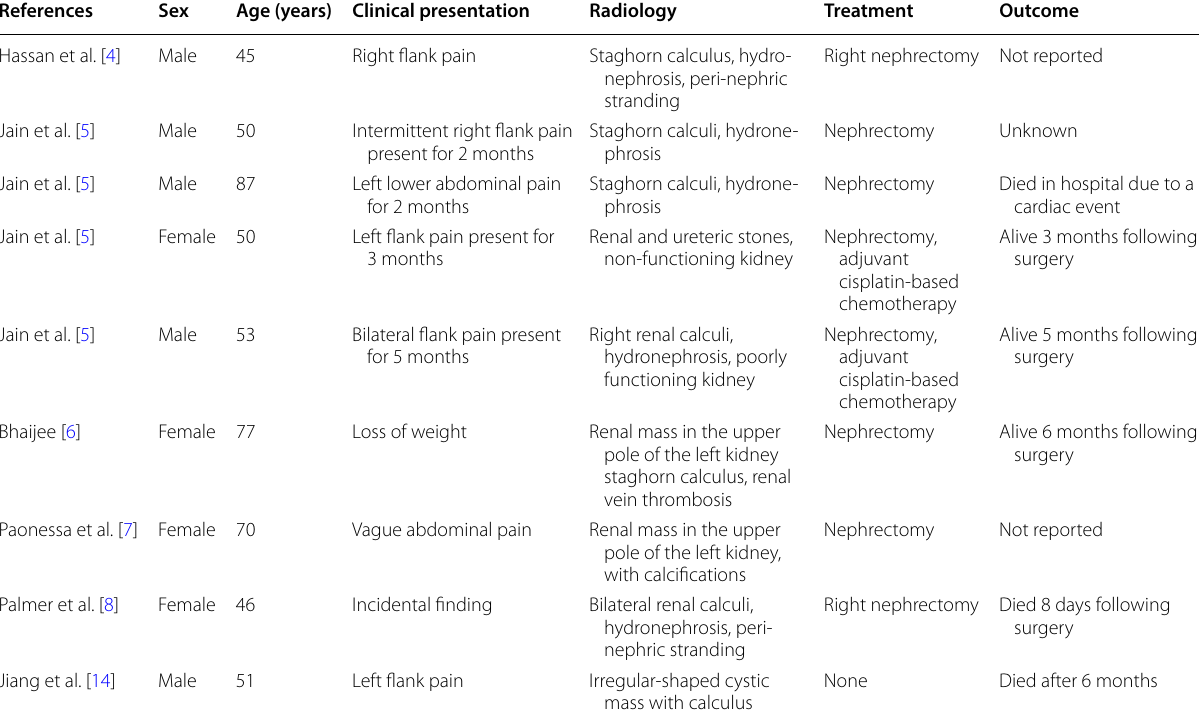
Table 1 Summary of clinical presentation, radiology, treatment, and outcome of renal squamous cell carcinoma